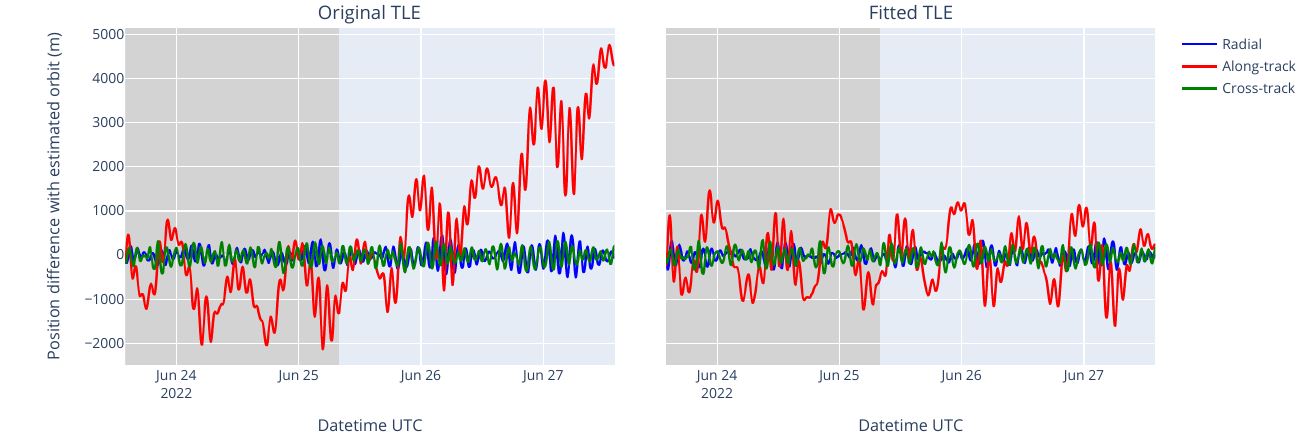
Figure 10. Position difference between an estimated orbit and two sets of TLE for an orbit determi- nation on 25 June 2022 with a 42 h arc. The darker gray area on the left of each figure represents the orbit determination window. ( Left ) Original TLE from Space-Track. ( Right ) TLE optimized by differential correction. The along-track error of the optimized TLE remained mostly periodic and within a ± 1 km range in the time interval